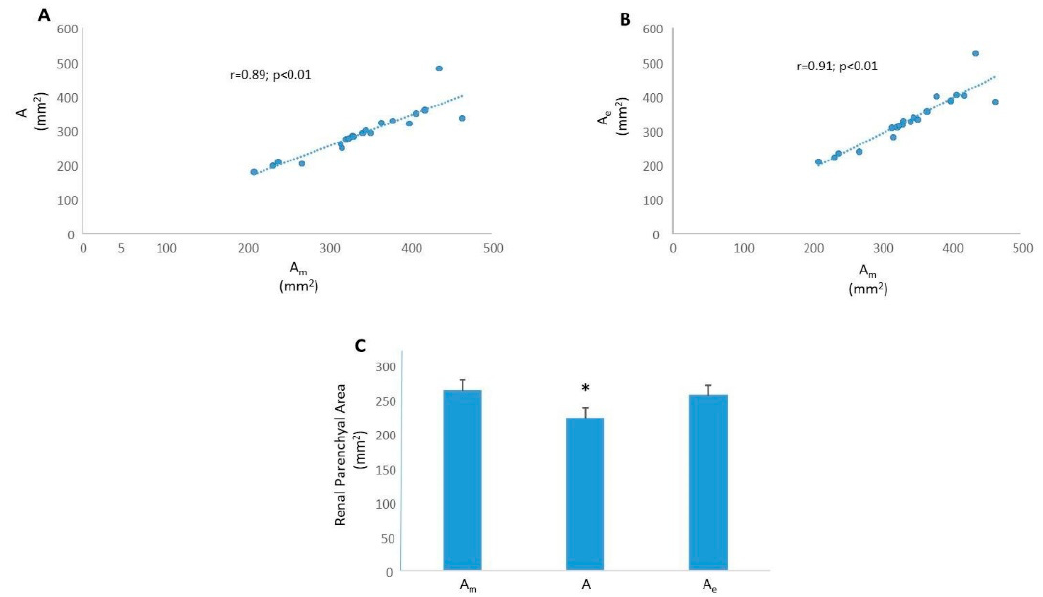
Figure 4. Right kidney parenchymal area in healthy and diseased rats. Right kidneys were sourced from adult male and female obese ZSF1 rats, adult male SD rats and adult male SD rats administered PAN and sliced coronally. ( A ) A scatter plot of A , the renal parenchymal area calculated using the existing ellipse-based formula vs. Am , the measured renal parenchymal area. ( B ) A scatter plot of Ae , the renal parenchymal area calculated using the modified ellipse-based formula with the extended minor axis vs. Am , the measured renal parenchymal area. ( C ) In coronal renal slices, Am is greater than A (*, p < 0.01) but not di ff erent from Ae